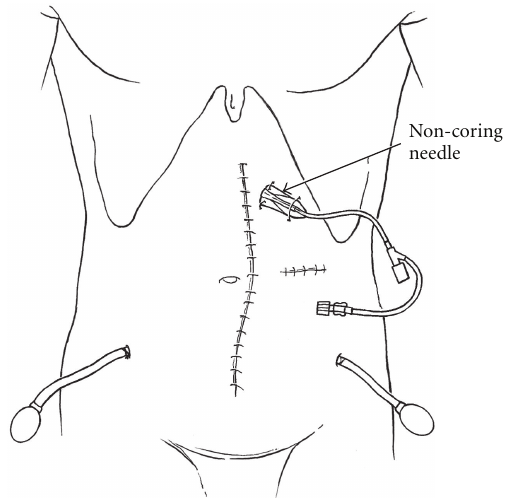
Figure 2: A noncoring needle is used to maintain optimal position of the port for 10 days.